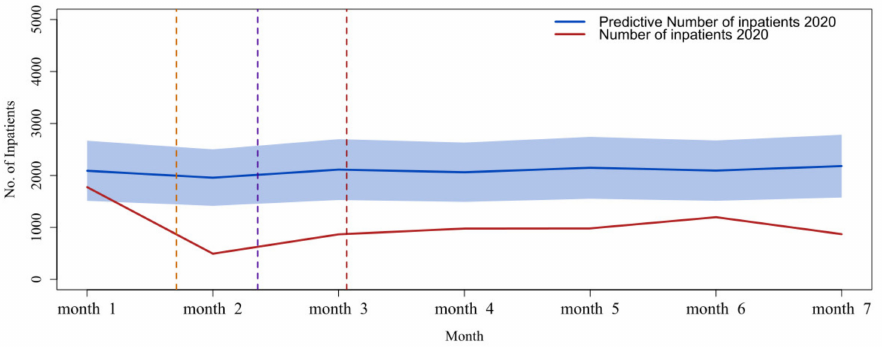
Figure 7. Comparison between observed inpatients and predicted inpatients from January to July 2020. The blue line is the ARIMA model estimate, and the blue-shaded region is the model 95% CI. Table 2. The observed and predicted number of inpatients with mental health during the COVID-19 outbreak in Shanghai.